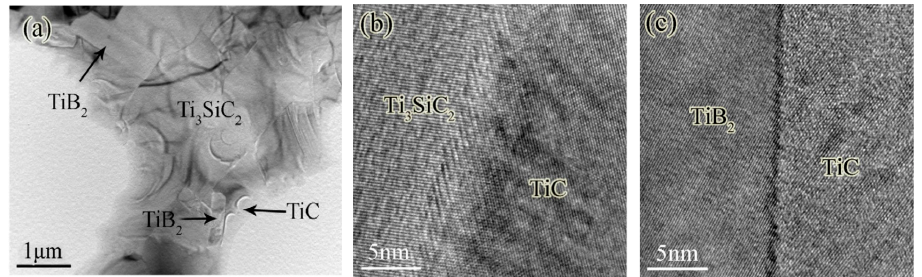
Figure 3. ( a ) TEM micrograph of the (TiB 2 +TiC)/Ti 3 SiC 2 composite with 10 vol % TiB 2 ; ( b ) HRTEM image of interface structure for Ti 3 SiC 2 and TiC; ( c ) HRTEM image of interface structure for TiB 2 and TiC [24].